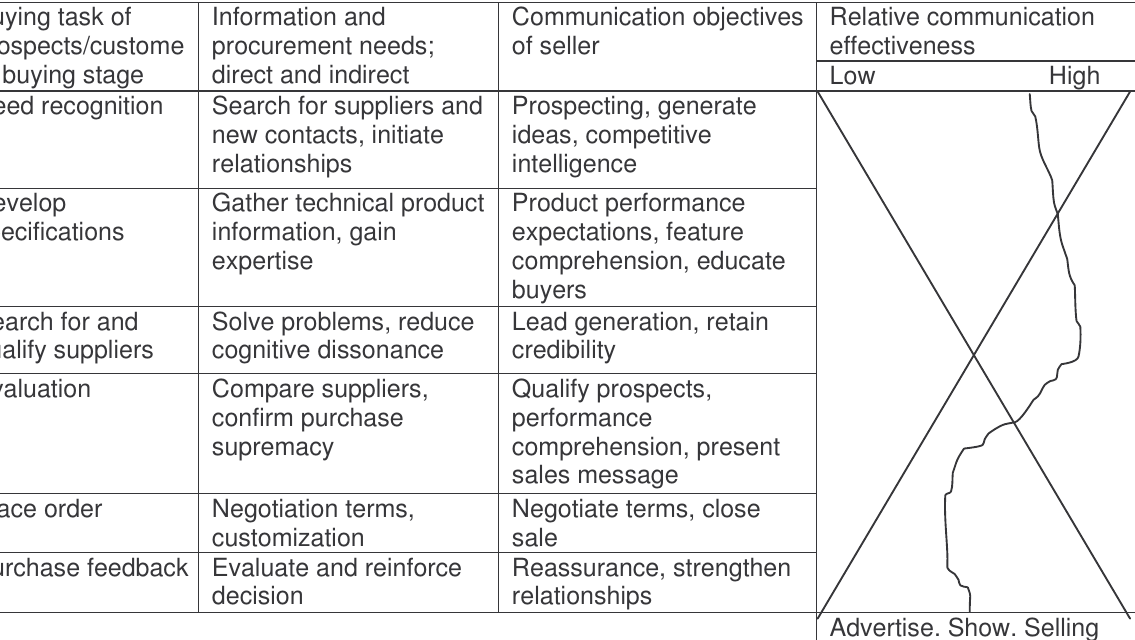
Table 2: Information and procurement needs based on buying tasks and stage in the buying